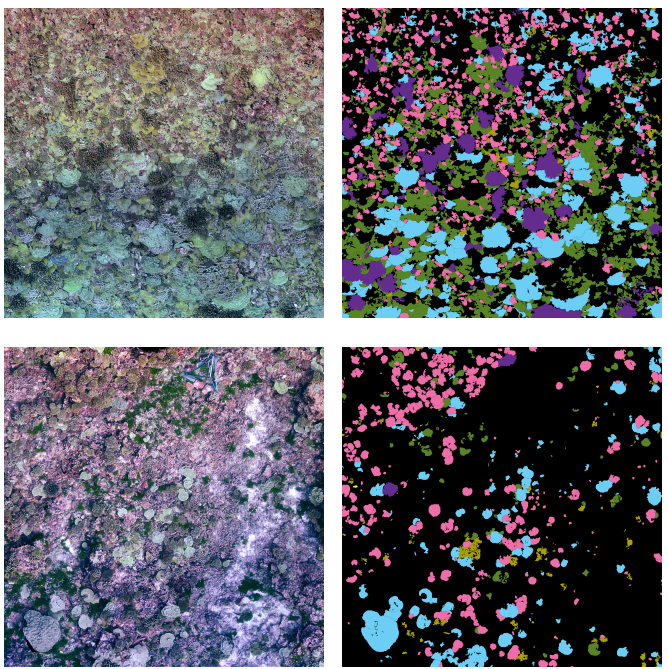
Figure 1. Orthoprojection and label map of the Fli-1 ( top row ) and Mil-4 ( bottom row